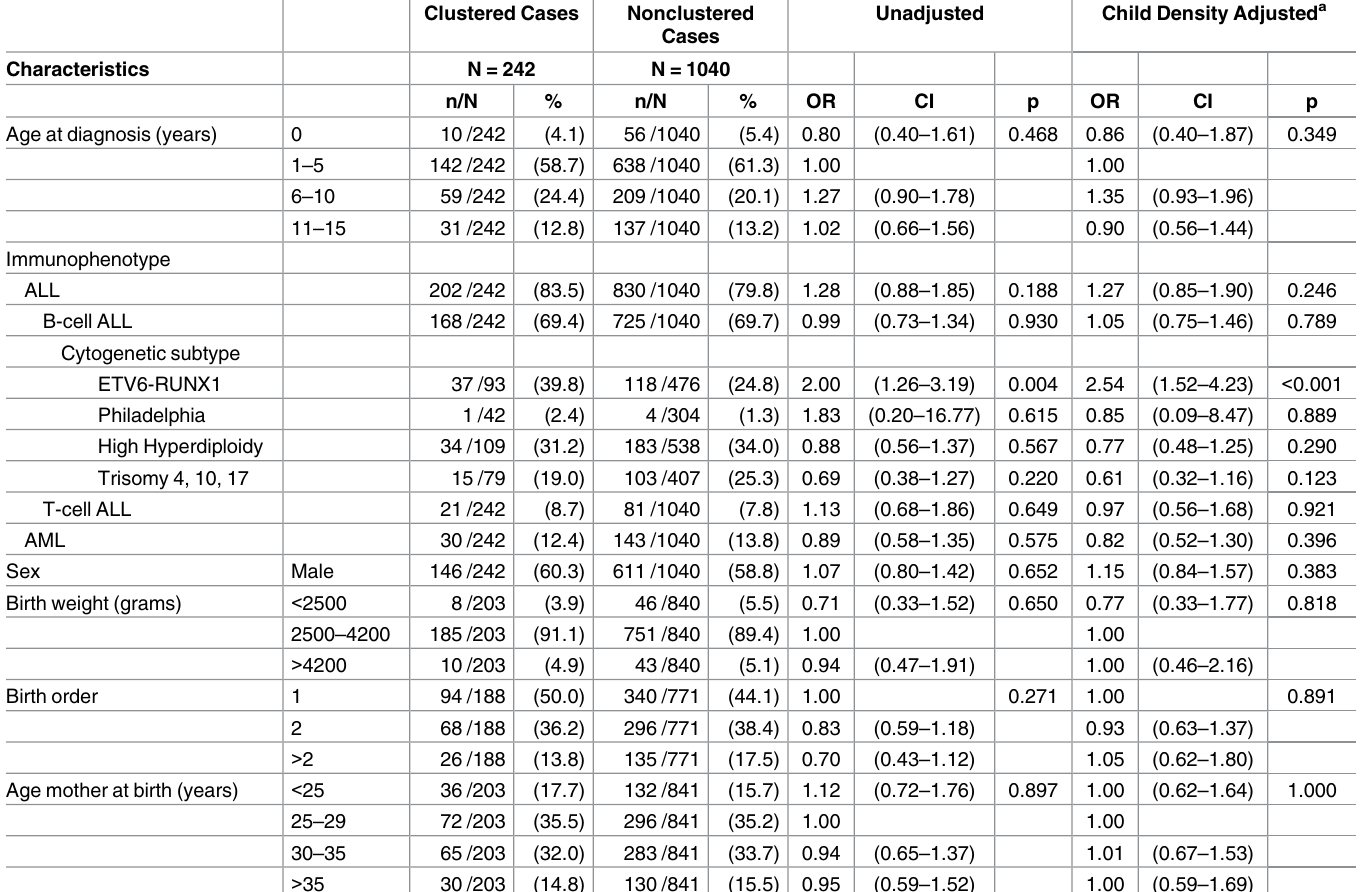
Table 2. Comparison of clinical and perinatal attributes between clustered * and nonclustered cases of CL both unadjusted and adjusted for local child population